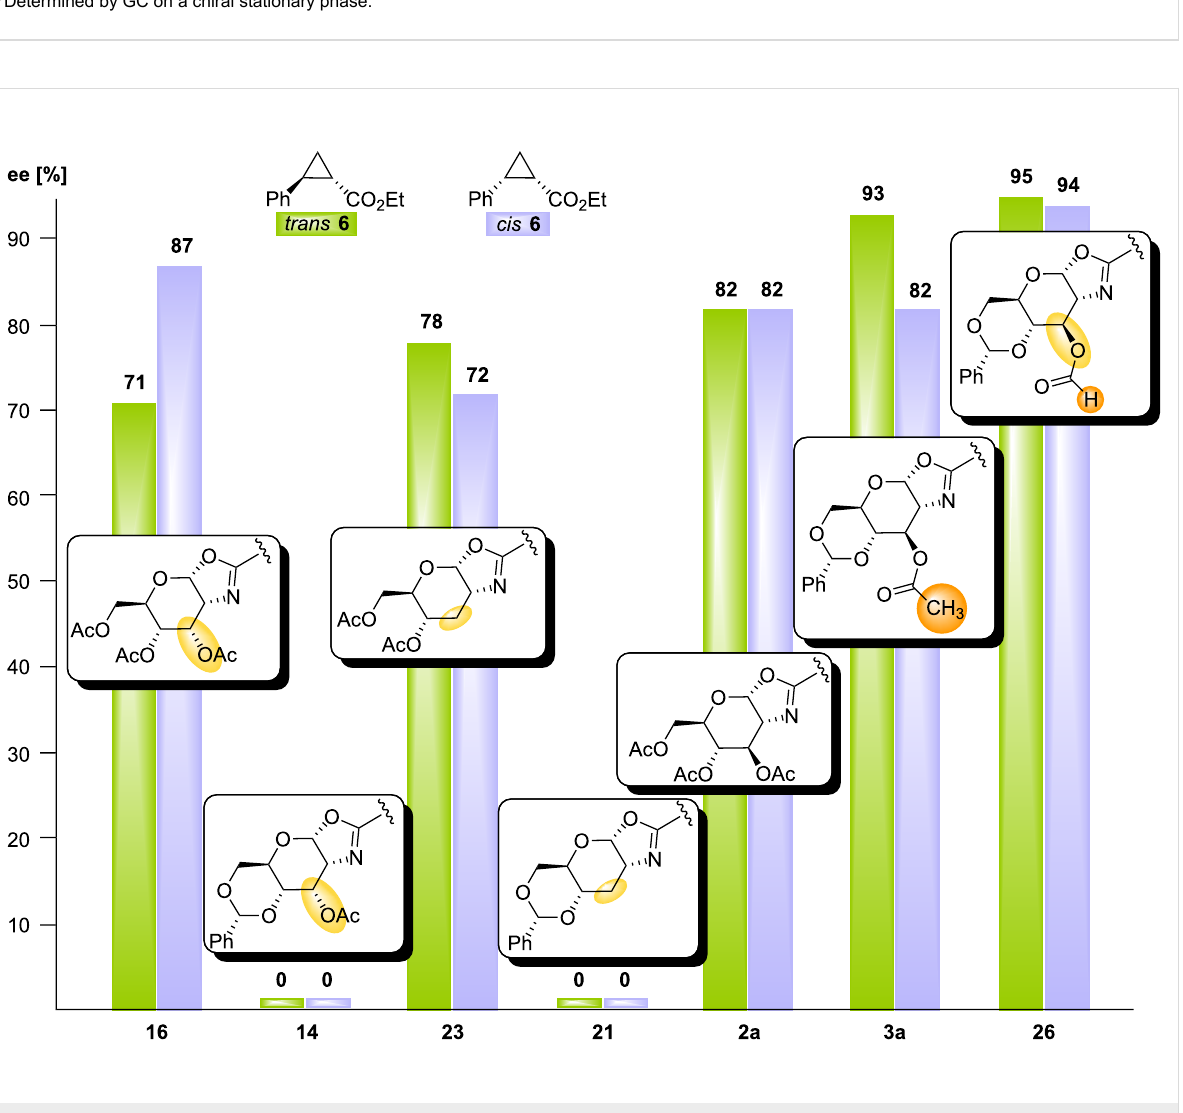
Figure 2: Impact of structural ligand modifications on the stereoselectivity of